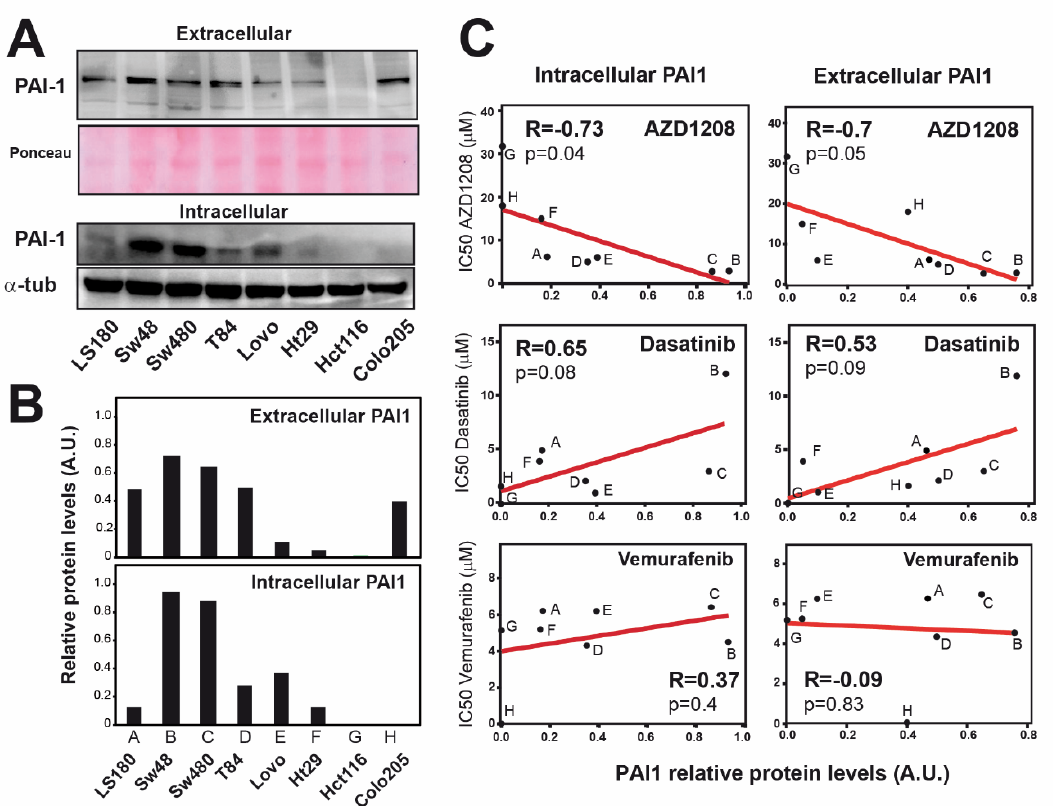
Figure 5. PAI1 expression correlates with sensitivity to the PIM inhibitor AZD1208 but not with Tyr Kinases inhibitor Dasatinib nor B-Raf inhibitor vemurafenib. ( A ) Intracellular and extracellular protein levels of PAI1 in CRC cell lines by Western blot. α -tubulin ( α -tub) is used as the intracellular loading control, and total protein as the extracellular control. ( B ) Quantification of PAI1 protein levels from ( A ) relative to α -tub for intracellular quantification or to total protein for extracellular quantification (total protein measured with Ponceau staining). ( C ) Scatter plots showing the IC 50 value (concentration that induces a 50% of cell death) to Vemurafenib, Dasatinib or the PIM inhibitor AZD1208 for the cell lines in ( A ), versus the PAI1 protein levels from ( B ). The Pearson’s R correlation coe ffi cient is shown with the associated P -value. IC 50 values plotted in C are the average of three independent experiments. The range of concentration for the drugs is 0 – 300 µM.